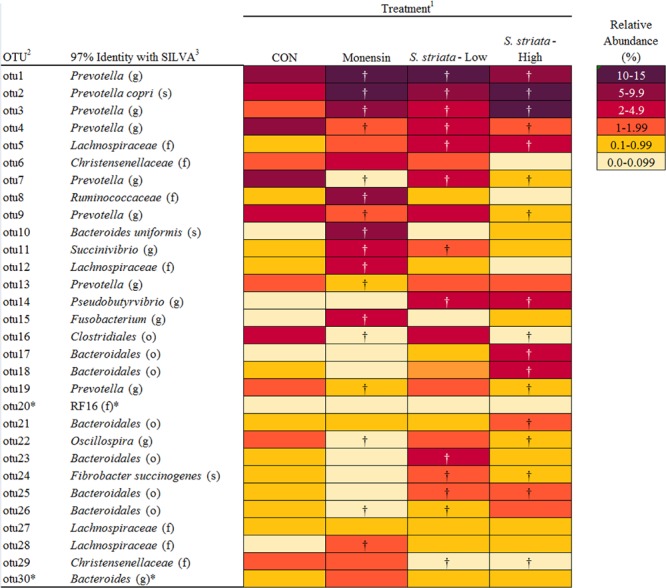
Effect of supplementation of Scrophularia striata extract and monensin on percent relative abundance and taxonomic classification of 30 most abundant operational taxonomic units (OTUs). 1Control: no additive; monensin: monensin, contained 0.83 mg g-1 of DM of substrate monensin sodium salt; S. striata-Low and S. striata-High contained 40 and 80 mg g-1 of DM of substrate dried plant extract, respectively. 2OTUs listed in order of relative abundance. 3Name of the closest relative based on 97% similarity in the sequence database at the class (c), order (o), family (f), genus (g), or species (s) level. †Adjusted mean separation based on Dunnett-Hsu shows a significant variation from the Control. ∗Means are not significantly different (P < 0.05).